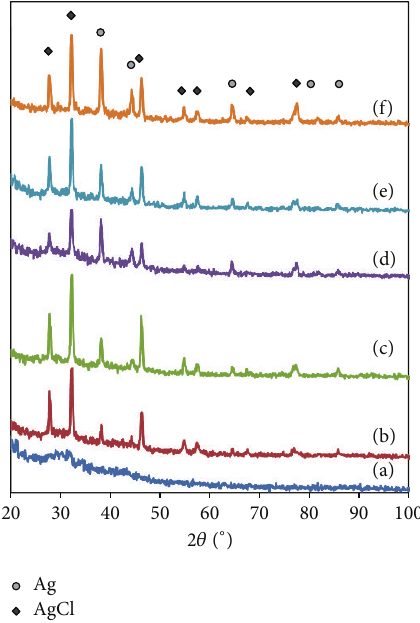
Figure 6: XRD pattern of HNO 3 functionalized 𝛼 CNTN/Ag nanohybrids at different molars of AgNO 3 : (a) 0 M, (b) 0.01 M, (c) 0.05 M, (d) 0.1M, (e) 0.5 M, and (f) 1M.